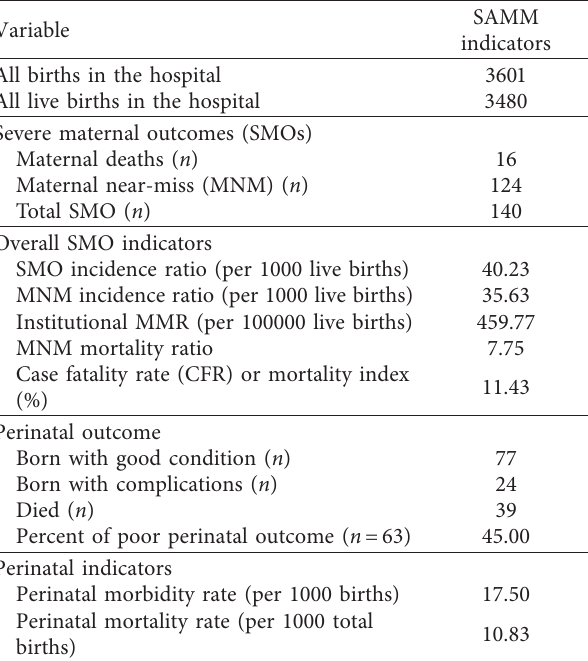
Figure 2: Major intervention/service provided for pregnant women with SMO, DRRH, Tanzania, January 2016, ( n � 140). ∗ n � 73, the total number of subjects who received blood transfusion. Table 2: Maternal and perinatal outcomes indicators among pregnant women with SMO, DRRH, Tanzania, January